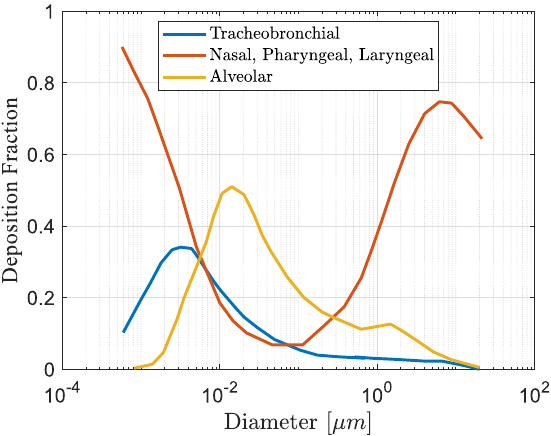
Figure 1. The representation of the deposition fraction of the particulate matter vs. particulate matter diameter in different parts of the airway system based on the International Commission on Radiological Protection (ICRP ) model.